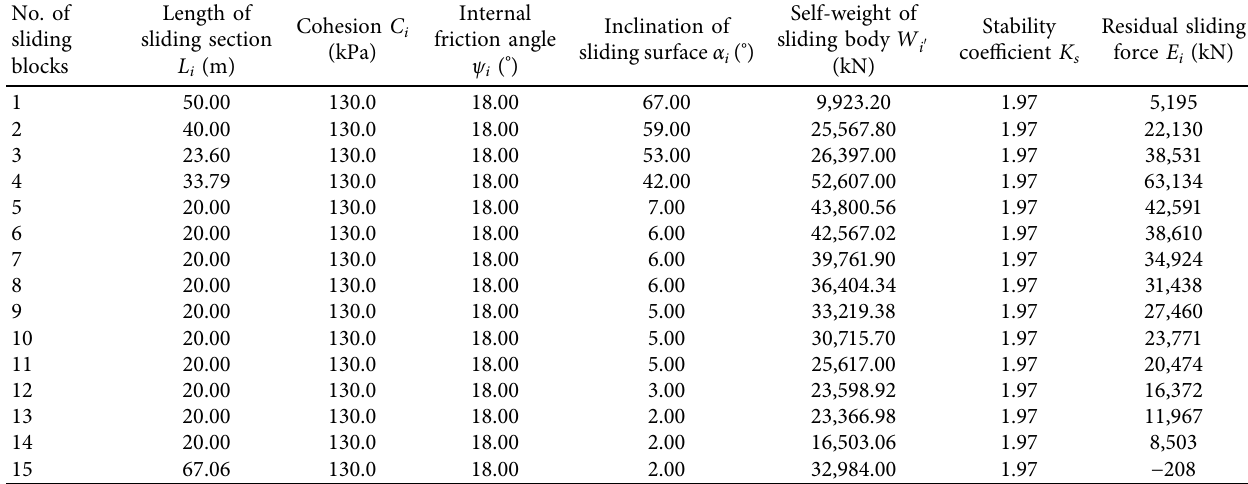
Table 8: Stability calculation for southern slope (case 1: sliding surface of soft layer).